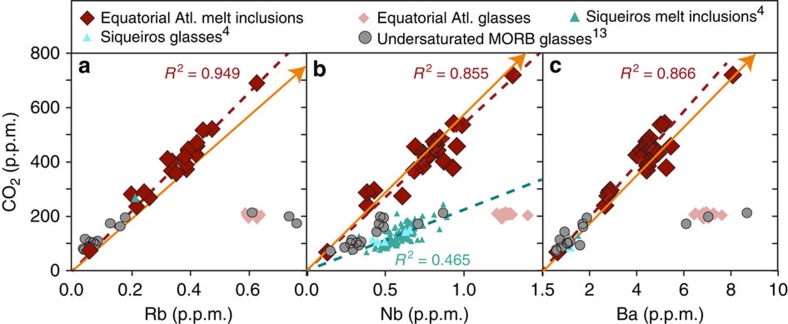
Variations in CO2 content as a function of highly incompatible trace elements.The CO2 content of the equatorial MAR melt inclusions and matrix glasses is represented as a function of Rb (a), Nb (b) and Ba (c), for, and compared to the Siqueiros melt inclusions and matrix glasses4, the popping rock (outside of the scale, represented by the arrow, CO2 and Nb (ref. 2); Rb and Ba (ref. 31)), and the undersaturated ultradepleted MORB glasses13. The single Siqueiros Rb point represents an average calculated using the Rb and Ba correlation found in Siqueiros melt inclusions48, applied to the maximum Ba measured in Siqueiros melt inclusions4. R2 values refer to the linear regressions (dashed lines) through each set of samples.